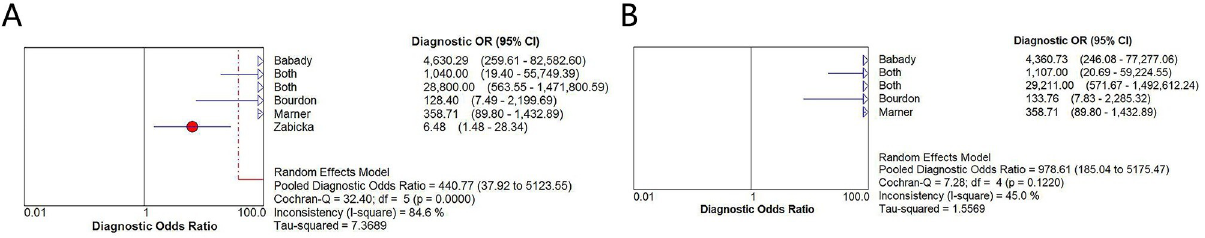
Fig 2. Forest plot for the pooled diagnostic odds ratio of vanA and vanB group. A Forest plot for DOR among 6 studies. B Forest plot for DOR among 5 studies (outlier study was excluded). After excluding the study, the I 2 value for heterogeneity decreased from 84.6% to 45%.